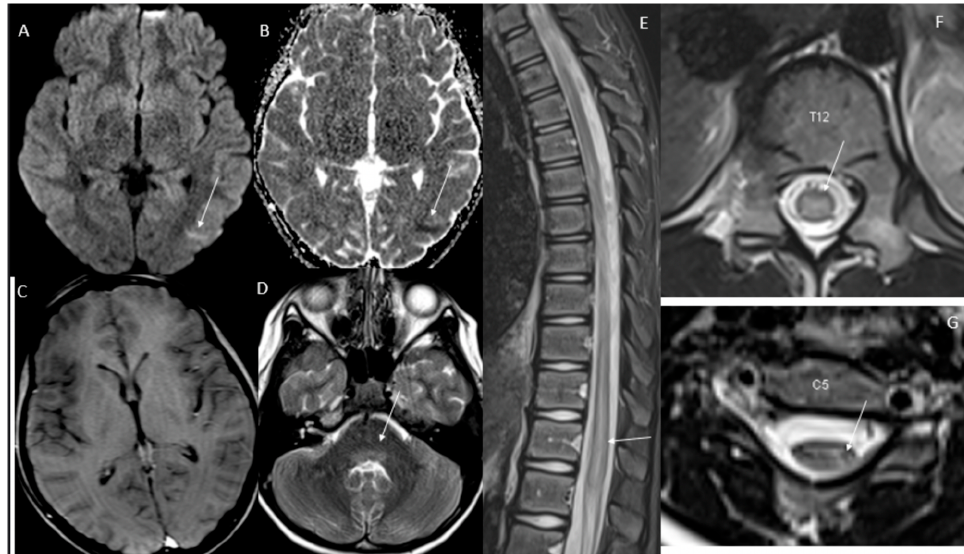
Figure 1. Initial axial DWI/ADC maps demonstrate subtle small area of restricted diffusion in left posterior temporal lobe (white arrows in images A,B ) and without perceivable enhancement (image C ). There is additional subtle T2 prolongation in the dorsal pons in the midline and paramedian region (white arrow image D ). Initial sagittal STIR image of the thoracic spine demonstrates scattered patchy areas of T2 prolongation with worst involvement of the lower cord and conus medullaris (white arrows in images E,F ). Additional patchy T2 prolongation is seen in left lateral cervical spinal cord at C5 (white arrow in image G ).